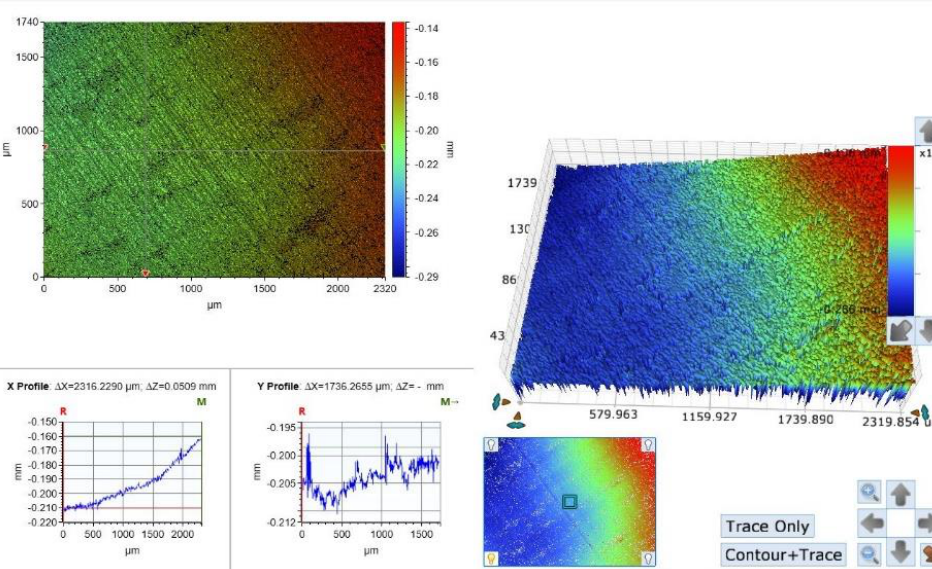
Figure 2. A surface scan photograph and a topography graph of a diamond burs group sample. Notice the homogenous parallel lines in the photo. Table 1. Surface RA values of tested groups.